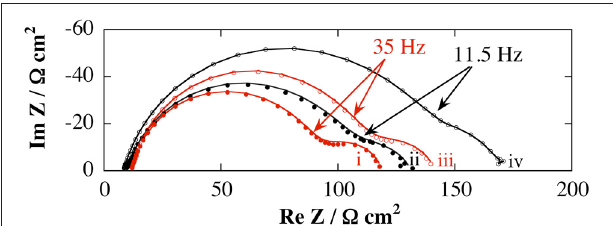
FIGURE 6 | Nyquist plot of impedance spectra obtained in the presence of 2 × 10 − 3 mol L − 1 of hydroquinone in 0.1mol L − 1 PB (pH 7.2); before and after incubation of 8 . 3 × 10 − 6 mol L − 1 of specific lectin (PNA or MAA). The frequency sweep was from 50kHz to 0.01Hz. Impedance measurements were performed at 0.35V vs. SCE with AC amplitude of 5mVrms at a rotation rate of 3000rpm. (i) poly(pyrrole-lactosyl) film ( (cid:3) = 2 . 1 × 10 − 9 mol cm − 2 ); (ii) poly(pyrrole-3 (cid:2) -sialyllactosyl) film ( (cid:3) = 2 . 0 × 10 − 9 mol cm − 2 ); (iii) MAA. Experimental (dots) and fitted data (lines) are presented.